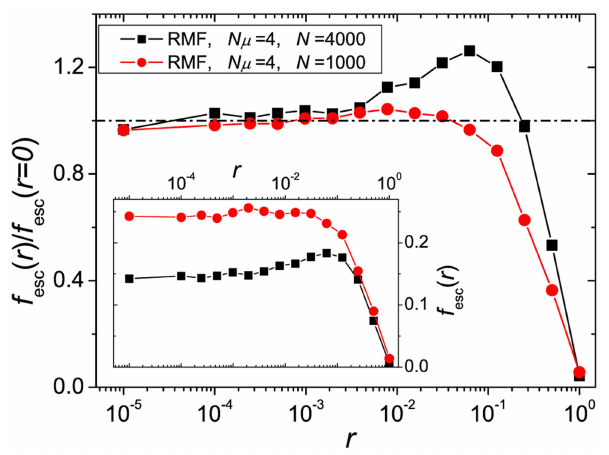
Figure 5. Escape from local maxima. Fraction of escape events f esc on RMF landscapes with l ~ c ~ 1 in dependence on the recombination rate r and normalized to the value at r ~ 0 . The inset shows the values without normalization. For suitable choices of the population parameters f esc ( r ~ 1) = f esc ( r ~ 0) has a maximum.